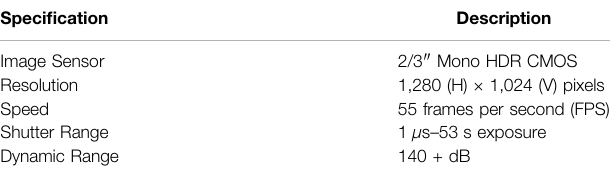
TABLE 2 | Xiris XVC-1000 speci fi cations (Bacioiu et al., 2019). Speci fi cation